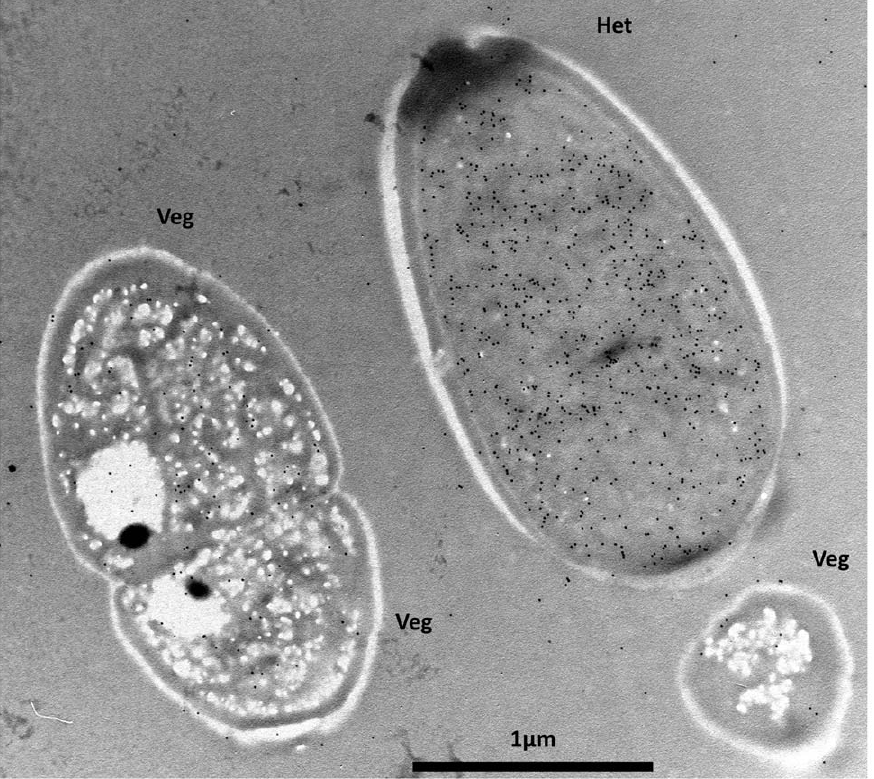
Figure 3. Immunogold-TEM localization of NifH in sectioned cells. Cultures grown in MLA 0 were harvested 3 hours into the light phase in 12L/12D cycle. Representative micrographs of a heterocyst (Het) and vegetative cells (Veg) are shown after being subjected to an anti-NifH antibody and detected by a secondary antibody conjugated to10 nm gold particles. The corresponding label intensity for each cell type is given in Table 2.